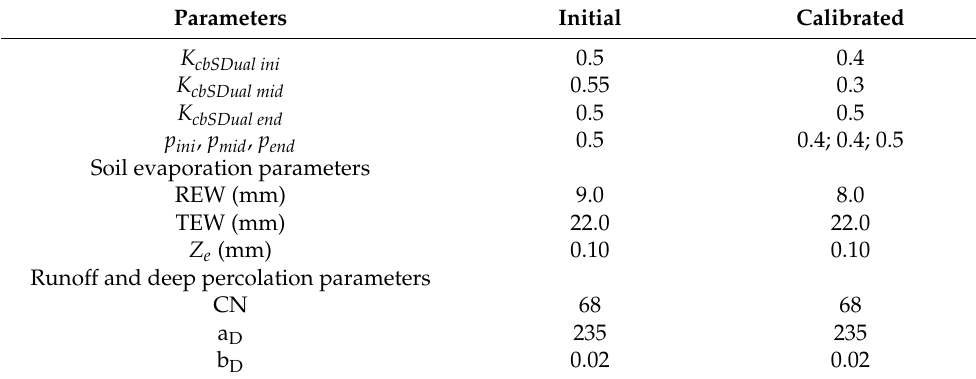
Table 2. Standard and calibrated parameters used in SIMDualKc model ( p —depletion fraction, K cb ini —basal crop coefficient for the initial crop development stage; K cb mid —basal crop coefficient for the mid stage; K cb end —basal crop coefficient for the end-season stage, M L parameter; TEW—total evaporable water; REW—readily evaporable water; Z e —thickness of the evaporation layer; CN—curve number; a D and b D —deep percolation